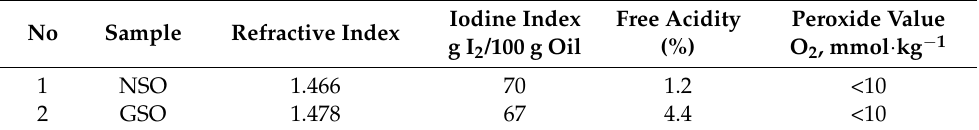
Table 1. Physicochemical properties of NSO and GSO.